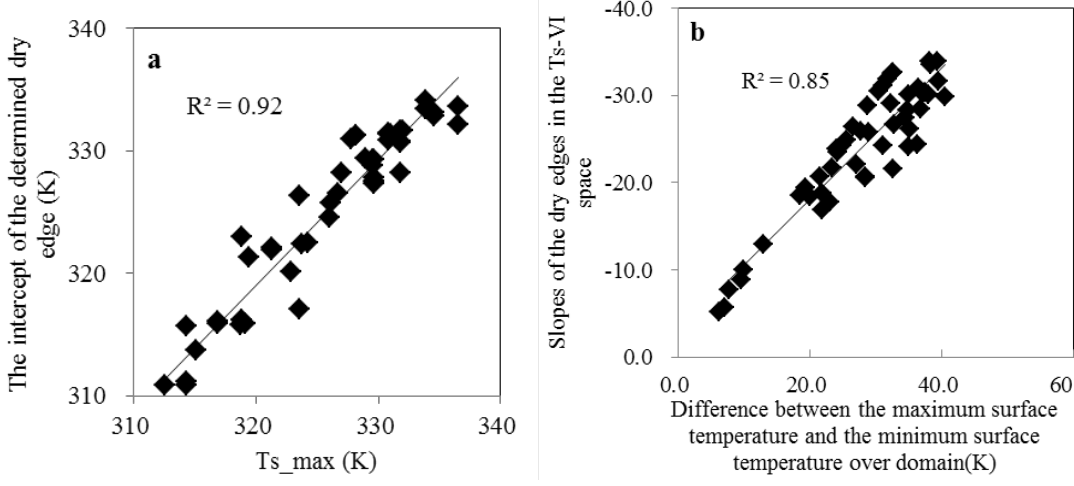
Figure 4. ( a ) Relationship between the intercept of the dry edge and the maximum surface temperature ( T s_max) for the 10 days for the five domains (50 points); ( b ) Relationship between the slope of the dry edge and the range of the surface temperature over the five domains for the 10 days (50